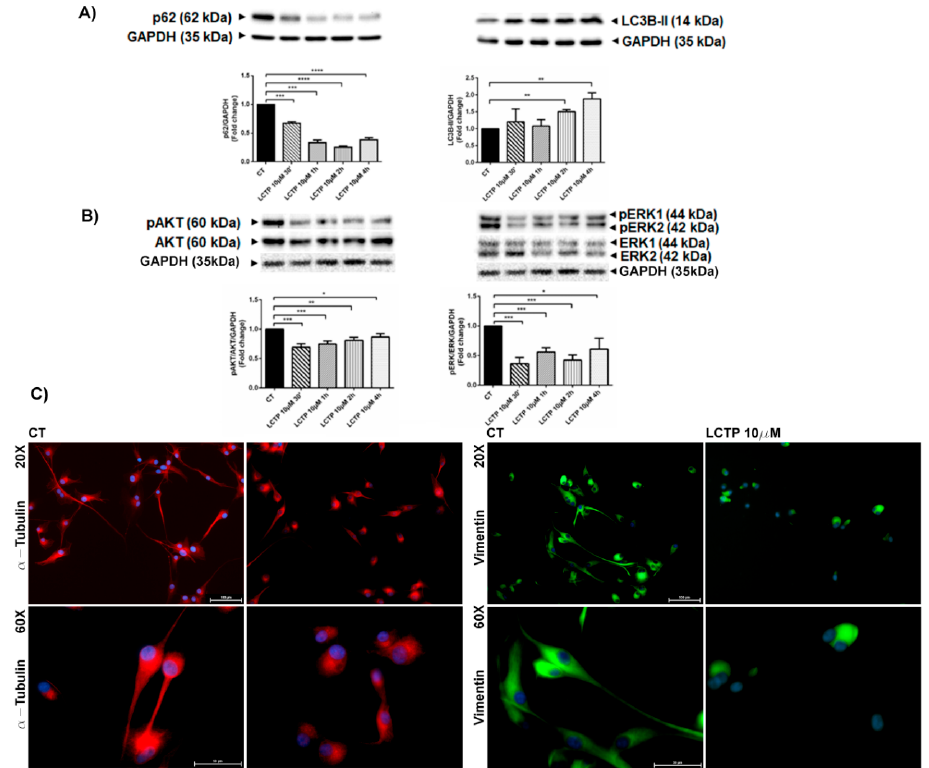
Figure 2. ( A ) Western blot analysis of autophagy-associated proteins p62 and LC3BII in short-termtreated-U87Mg cells with LCTP 10 µ M. Densitometric analysis of protein levels represent the means ± SEM of 3 individual determinations. Data were normalized to GAPDH and are expressed as fold change over control-treated cells. * Unpaired t -test, p -value < 0.05. ( B ) Western blot analysis of proliferative signals pERK / ERK / GAPDH and pAKT / AKT / GAPDH in short-termtreated-U87Mg cells with LCTP 10 µ M. Densitometric analysis of protein levels represent the means ± SEM of 3 individual determinations and are expressed as fold change over control-treated cells, normalized to GAPDH. * Unpaired t -test, p -value < 0.05. According to GraphPad Prism, * p -value 0.01 to 0.05 (significant), ** p -value 0.001 to 0.01